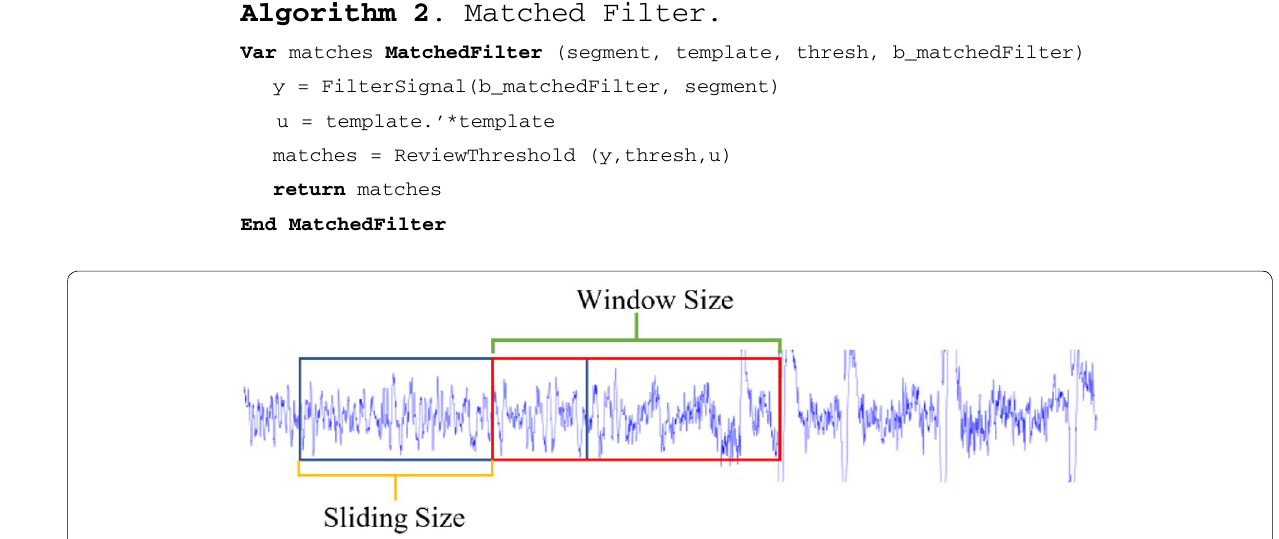
Algorithm 2 . Matched